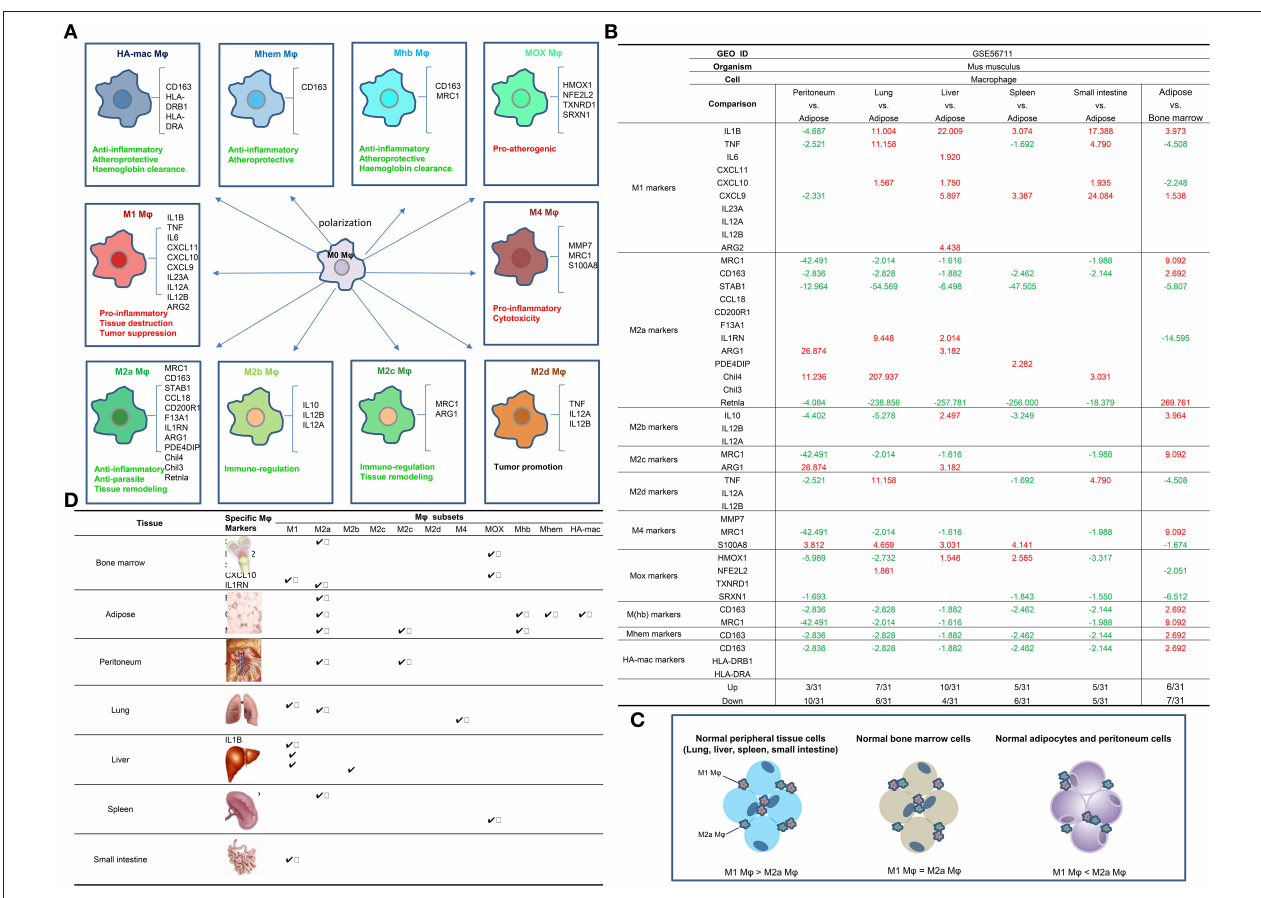
FIGURE 2 | (A) Macrophages (M ϕ ) can be polarized into 10 (potentially more) different subsets, and the markers and main functions of 10 M ϕ subsets are different (PMID: 24998279; 25319333; 25973901). M1, M4, and Mox are proinflammatory while the rest of the M ϕ subsets are anti-inflammatory. (B) Mechanism I: The 10 macrophage (M ϕ ) subset markers ( 30) are differentially expressed in macrophages from various tissues, and lung, liver, spleen, and small intestine upregulate more M1 M ϕ markers than M2 M ϕ markers in the physiologic condition in comparison to lean ATM ϕ . (1) Retnla, CD163, and MRC1 are relatively adipose tissue-specific M ϕ (ATM ϕ ) markers; (2) STAB1, NFE2L2, and SRXN1 are relatively bone marrow-specific M ϕ markers; (3) ARG1 is a relatively specific M ϕ marker for peritoneum, Chil4 is a relatively specific M ϕ marker for lung, IL1B is a relatively specific M ϕ marker for liver, PDE4DIP and HMOX1 are relatively specific M ϕ markers for spleen, and CXCL9 is a relatively specific M ϕ marker for small intestine. (C) M ϕ subset markers are differentially expressed in various tissues. (D) Tissue M ϕ have different compositions of M ϕ subsets as judged by the expressions of M ϕ subset markers. (1) The genes of macrophage subtypes such as Mhb, Mhem, and HA-mac are relatively adipose tissue-specific. (2) The genes of Mox are bone marrow macrophage-specific. (3) Retnla is a M2a subset marker in peripheral tissues. (4) ILIB and CXCL9 are specific markers for small intestine M1 macrophages. (5) ARG1 is a specific marker for peritoneal M2a and M2c macrophages.